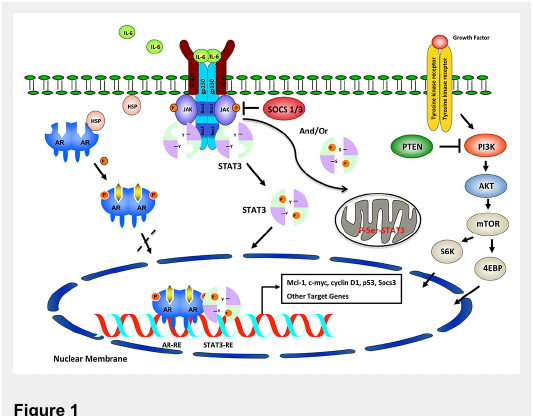
Overview of IL-6/STAT3/ARF and PI3K/PTEN/AKT/mTOR pathways. Activation of IL-6/STAT3 signalling leads to phosphorylation and translocation of STAT3 to the nucleus, which is associated with AR interaction regulated by HSP. JAKs serve to phosphorylate tyrosine (Y) or serine (S) residues of STAT3 and to translocate to nucleus or mitochondrial matrix. Some of these downstream signalling events (STAT3-AR-S6K) could regulate activity or expression of prostate cancer related genes. ARF = alternative reading frame protein; IL-6 = interleukin-6; PI3K = phosphatidylinositol-3-kinase; PTEN = phosphatase and tensin homologue; STAT3 = signal transducer and activator of